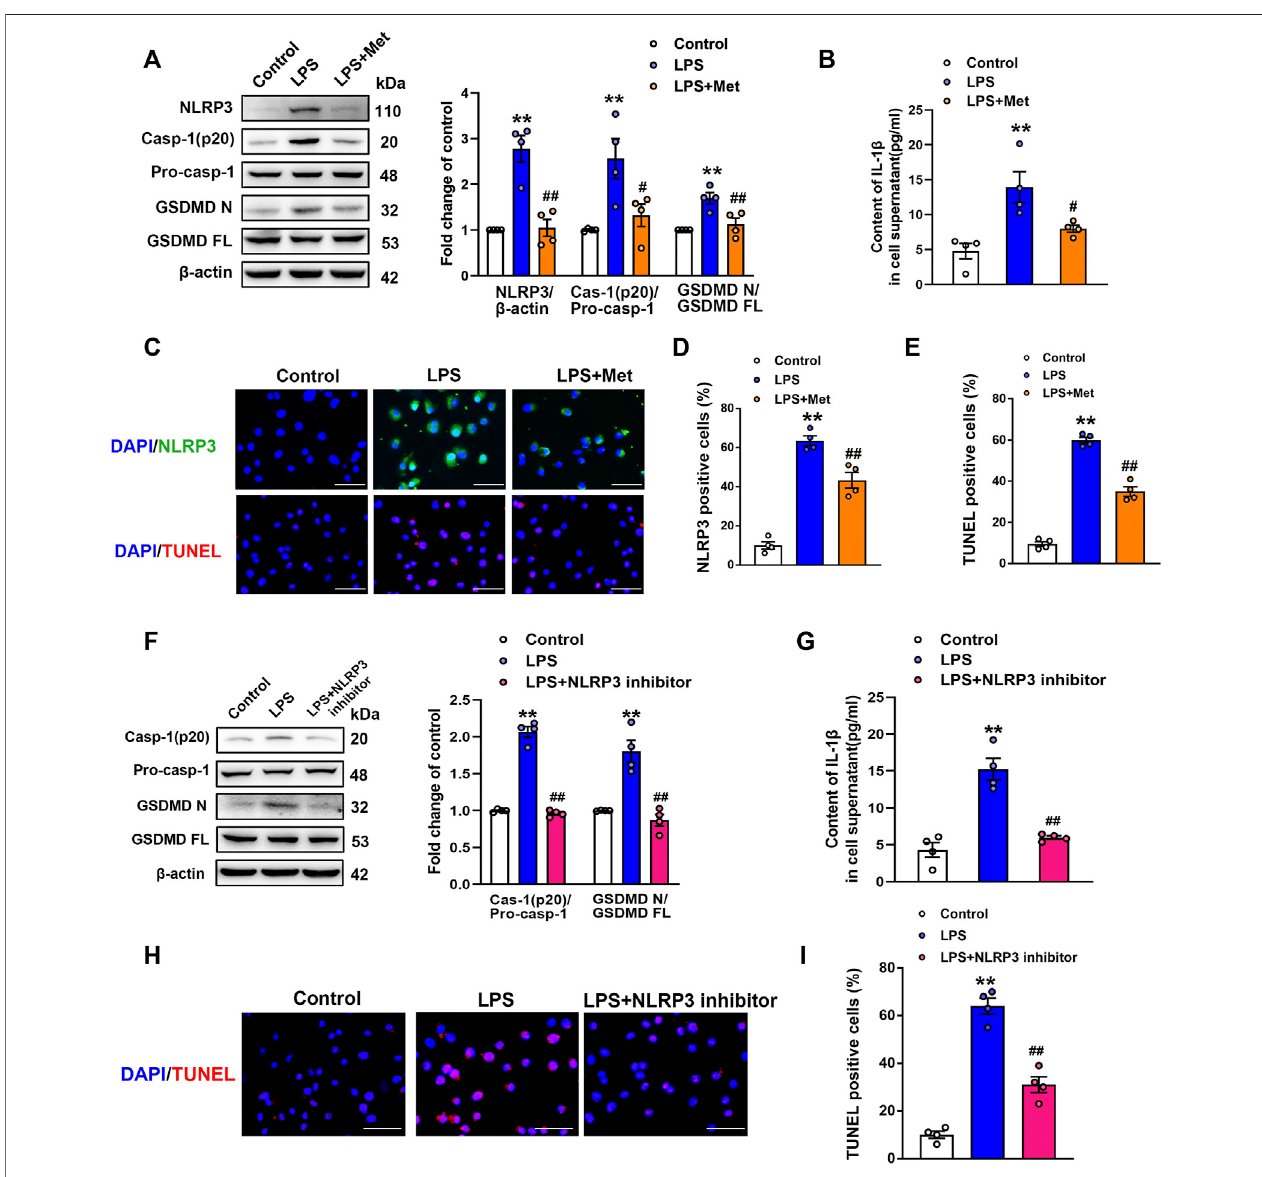
FIGURE3| MetforminandNLRP3inhibitorreducetheLPS-inducedreleaseofpyroptotic proteinsandin fl ammatorycytokinesinprimarilyculturedpulmonaryECs of mice. Pulmonary ECs were pretreated with metformin (10 mM) and NLRP3 inhibitor (MCC950, 10 μ M), and then ECs were exposed to LPS for 24 h. (A) Indicative protein bands of NLRP3, cleaved caspase 1 (p20), and N-terminal fragment of GSDMD. (B) ELISA was used to determine the protein levels of IL-1 β in the supernatant. (C) ECs werestained withNLRP3(green).Apoptotic cellswereevaluatedusing TUNELstaining.Thenucleiwere stainedblue usingDAPI. (D) and (E) Percentages of NLRP3-positive cells and TUNEL-positive cells. (F) Effect of MCC950 pretreatment on the expression levels of pyroptosis-related proteins was analyzed by Western blotting.Quantitativeanalysisofpyroptosis-relatedproteinexpressionwasconducted.Representativebandsareshownontheleftofthehistogram. (G) ELISAwasused to determine the protein levels of IL-1 β in supernatants. (H) DNA fragmentation was determined using TUNEL staining. The nuclei were stained blue using DAPI. (I) Percentage of TUNEL-positive cells. Magni fi cation: ×200. Scale bar, 50 μ m. Data are presented as the mean ± SEM ( n = 4). ** p < 0.01 vs. Control group, # p < 0.05, ## p < 0.01 vs. LPS